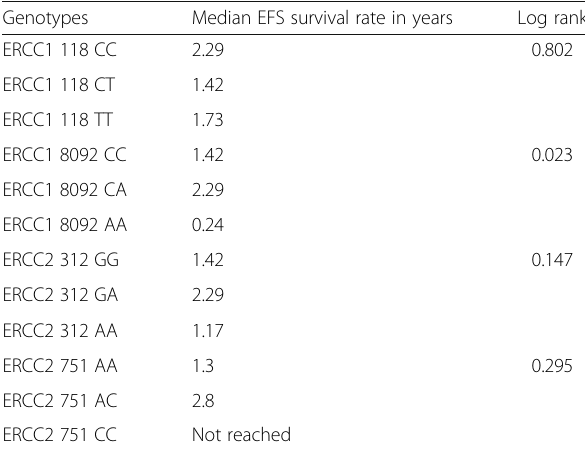
Table 5 Association between genotypes and median (EFS) rate in osteosarcoma patients treated with cisplatin combination Genotypes